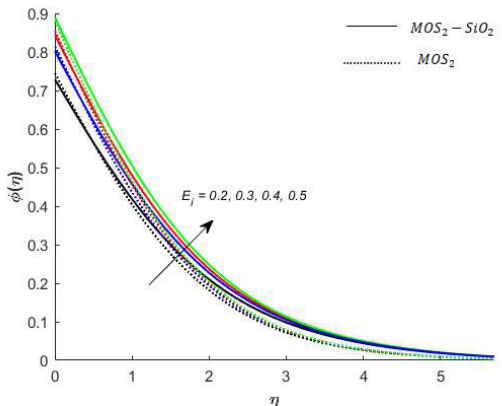
Figure 14. Variation in concentration for 𝑆𝑐 when 𝑀 = 0.2,𝑃𝑟 = 2.36,𝑆𝑟 = 0.1,(𝐺𝑟) (cid:3030) = 0.1,𝐾 = 0.1, 𝐵 (cid:3036) = 0.05,and 𝛽 ∗ = 0.1 .